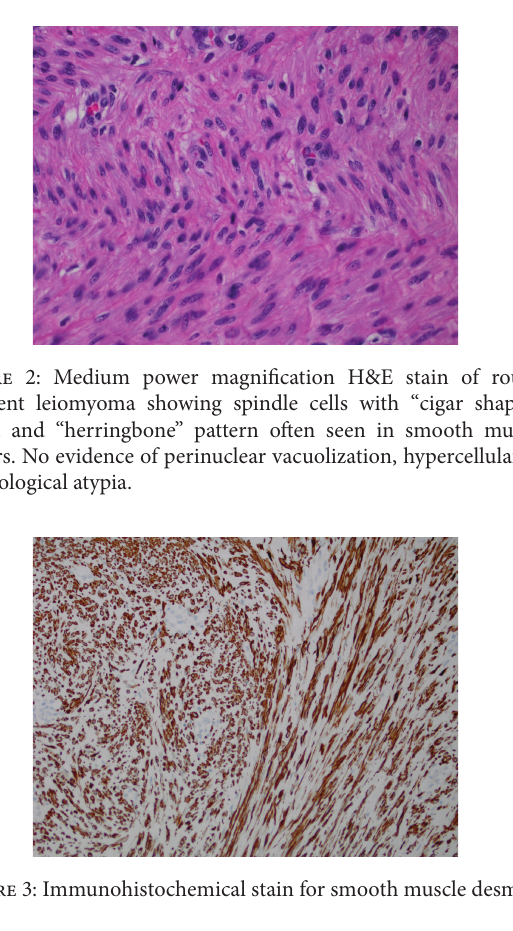
included closure of the ring and placement of a lightweight mesh